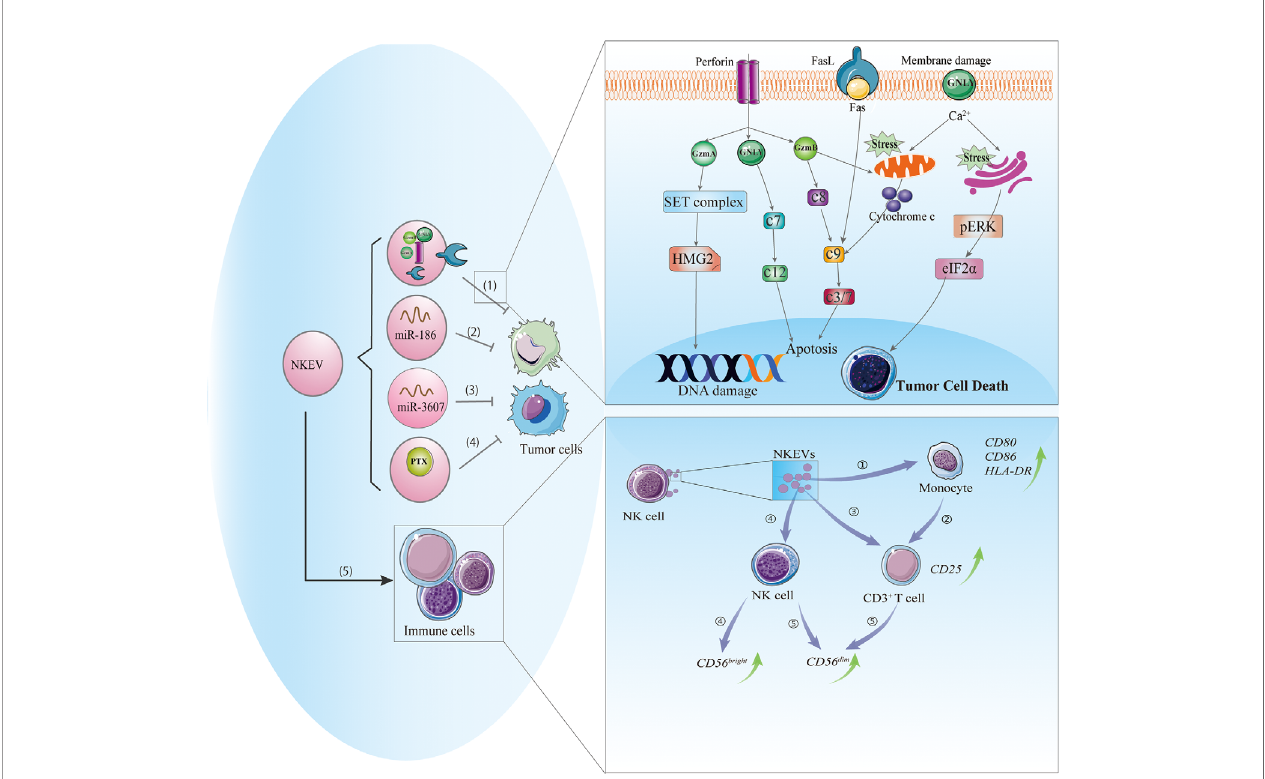
FIGURE 1 | Cytotoxic and immunomodulatory effects of NKEVs. NKEVs carry numerous bioactive molecules such as cytotoxic proteins, microRNAs, and therapeutic drugs that can exert antitumor effects. (1) NKEVs containing cytotoxic proteins can kill tumor cells through caspase-dependent and -independent apoptotic pathways. Granzyme A induces the cleavage of the SET protein complex, leading to single-stranded DNA damage. Granzyme B directly activates procaspase and disrupts mitochondria, causing the release of cytochrome c and activation of the apoptotic cascade. Granulysin damages the cell membrane and induces ER stress-mediated apoptosis. (2) MiR-186 in NKEVs downregulates MYCN and AURKA expression, thereby inhibiting cell proliferation and inducing apoptosis of neuroblastoma cells. (3) MiR-3607-3p in NKEVs inhibits pancreatic cancer cell migration and invasion by targeting IL-26. (4) NKEVs loaded with paclitaxel can kill breast cancer cells. (5) NKEVs can stimulate immune cells. 1) NKEVs induce the expression of costimulatory molecules on monocytes. 2) NKEVs activate T cells by acting on monocytes. 3) NKEVs directly activate T cells by inducing the upregulation of CD25. 4) NKEVs stimulate NK cells, predominately the CD56 bright subgroup. 5) In the presence of T cell and monocyte stimuli, NKEVs increase the percentage of CD56 dim NK cells. Abbreviations: AURKA, Aurora kinase A; GNLY, granulysin; GzmA, granzyme A; GzmB, granzyme B; c3/7, caspase3/7; c7, caspase 7; c8, caspase8; c9, caspase9; c12, caspase 12; IL-26, interleukin 26; MYCN, V-Myc avian myelocytomatosis viral oncogene neuroblastoma-derived; NKEV, NK cell-derived extracellular